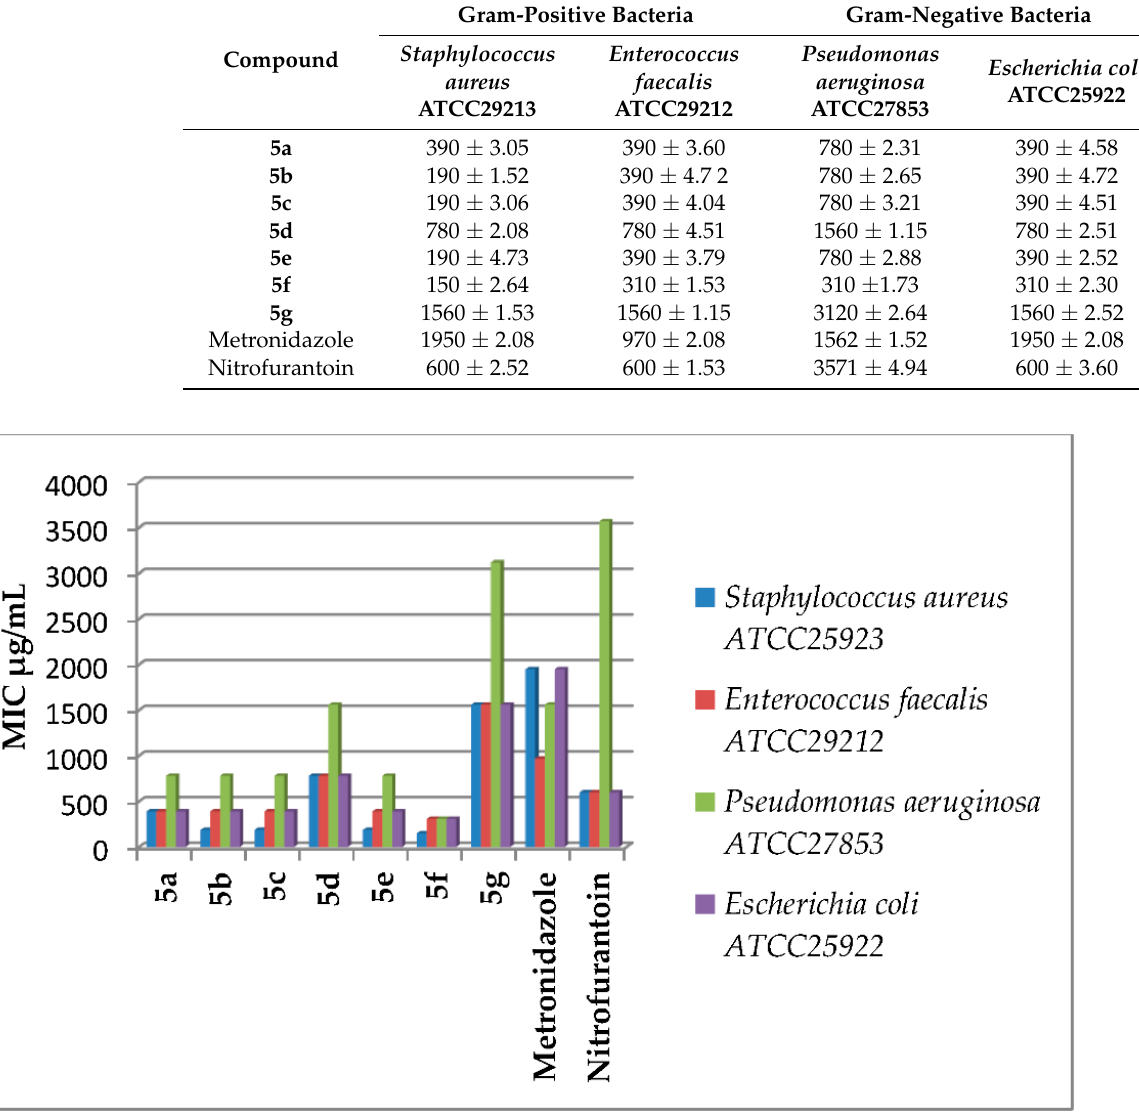
Figure 5. MIC ( μ g/mL) values of the tested compounds. Figure 5. MIC ( µ g/mL) values of the tested Table 3. The minimum inhibitory concentration ( μ g/mL) of test compounds 5a–g .